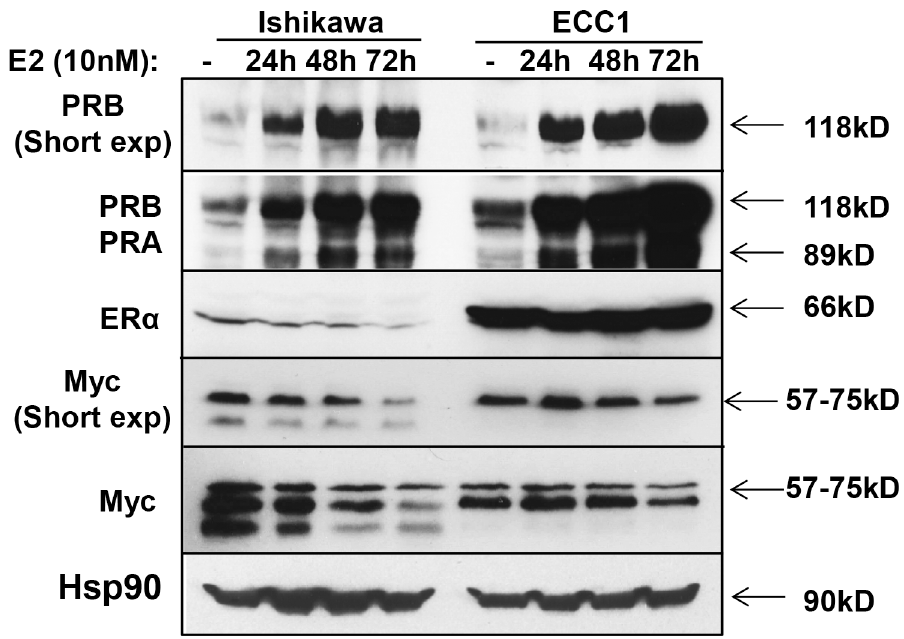
Fig 3. Activation of ER α with estrogen simultaneously increases PR expression and decreases Myc expression in endometrial cancer cells. Ishikawa and ECC1 cells were treated with 10 nM estradiol (E2) for indicated times. PR, Myc and ER α protein expression was measured by Western blotting. Hsp90 serves as loading